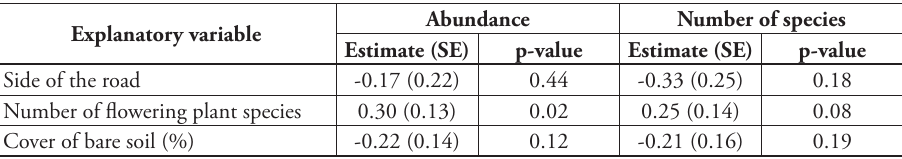
Table 2. The abundance and number of species of bees and wasps (Aculaeta) in relation to the side of the road, number of flowering plants and the cover of bare soil based on generalized linear mixed models (Poisson error